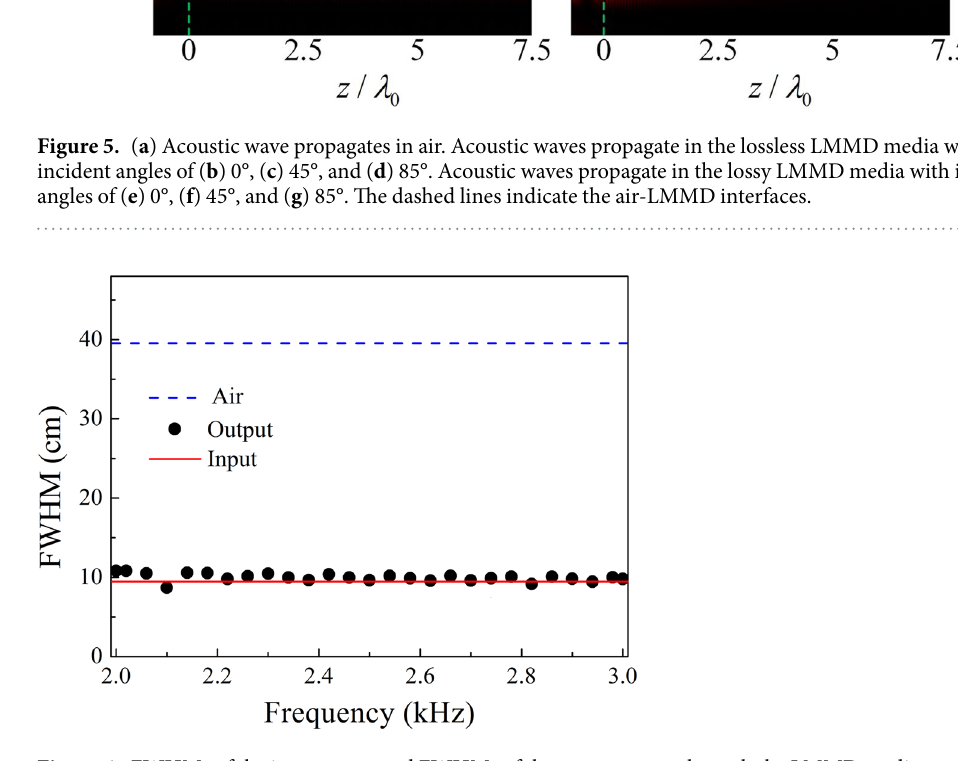
Figure 6. FWHMs of the input waves and FWHMs of the output waves through the LMMD medium as a function of frequency. The dashed line shows the FWHMs of the Gaussian waves after propagating a two- wavelength distance in